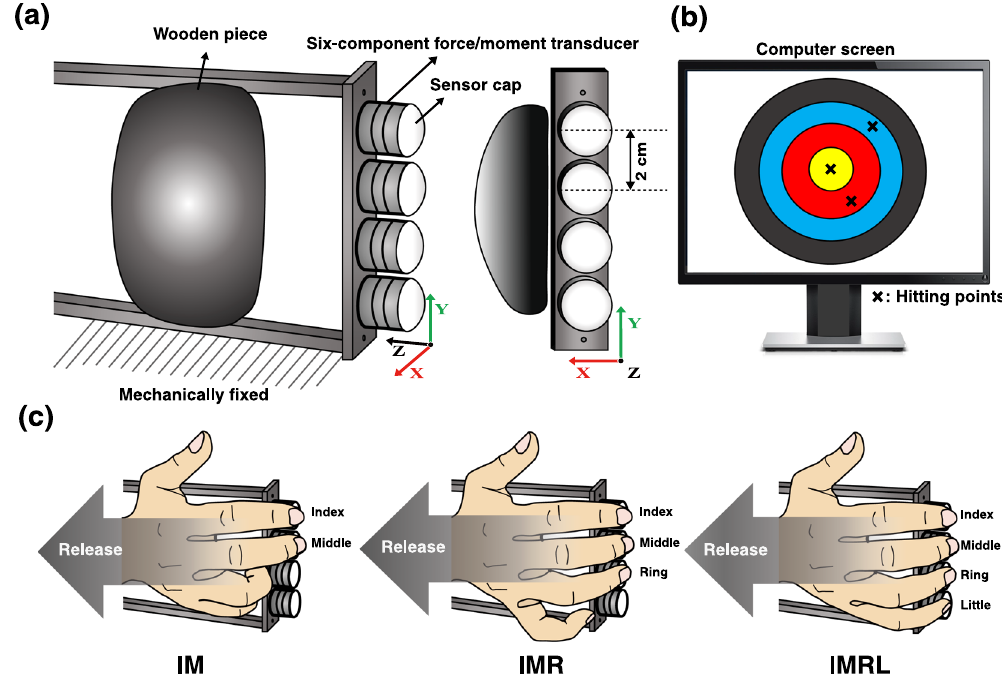
Figure 6. An illustration of the experimental equipment and conditions. ( a ) The experimental frame was mechanically fixed to the table and the sensors were attached to the experimental frame (size: 90 × 140 × 250 mm). The uncertainty values of the transducers as the validity of measurement were measured. The estimated results show the measurement errors ranged from 0.02–0.05 N for the force and 0.02–0.06 Ncm for the moment of force, which are compatible with the values reported in the previous studies 43,44 . Finely round-shaped caps were inserted into the surface of the transducers, which allowed fingertips to have intentional roll or slide naturally. The distance between adjacent transducers was set at 2 cm along the y-axis, and a wooden piece was placed under the palm to ensure a consistent configuration of the hand and fingers during the tasks 45 . The sampling rate of the force signals was set at 100 Hz. A 27-inch computer screen was positioned in front of the subject, which provided real-time force feedback. The refresh rate of the feedback screen was 60 Hz. ( b ) The computer screen displayed a hitting point of the virtual ball after the completion of a particular trial. The computer screen showed F TOT produced by the participants and F REF . After the completion of a particular trial, the computer screen showed a hitting point of the virtual ball by assuming that the trajectory of the ball was determined by the velocity at the moment of release and gravitational force ( g = 9.81 m/s 2 ) acting on the ball. ( c ) Hand and finger configurations for three experimental conditions. The thumb was parallel to the fingers and naturally flexed the proximal interphalangeal joint to 10–20°. Similarly, non-involved fingers in the IM and IMR conditions were also flexed naturally while not contacting transducers; therefore, the thumb and non-involved finger(s) had no mechanical effect on the frame during the